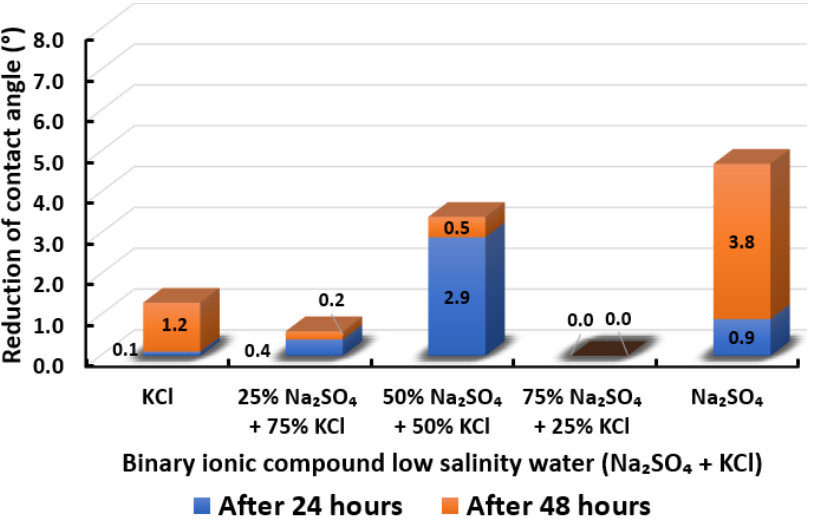
Figure 21. Contact angle reduction results for binary ionic compounds smart water (SW) solutions Na 2 SO 4 + KCl (3500